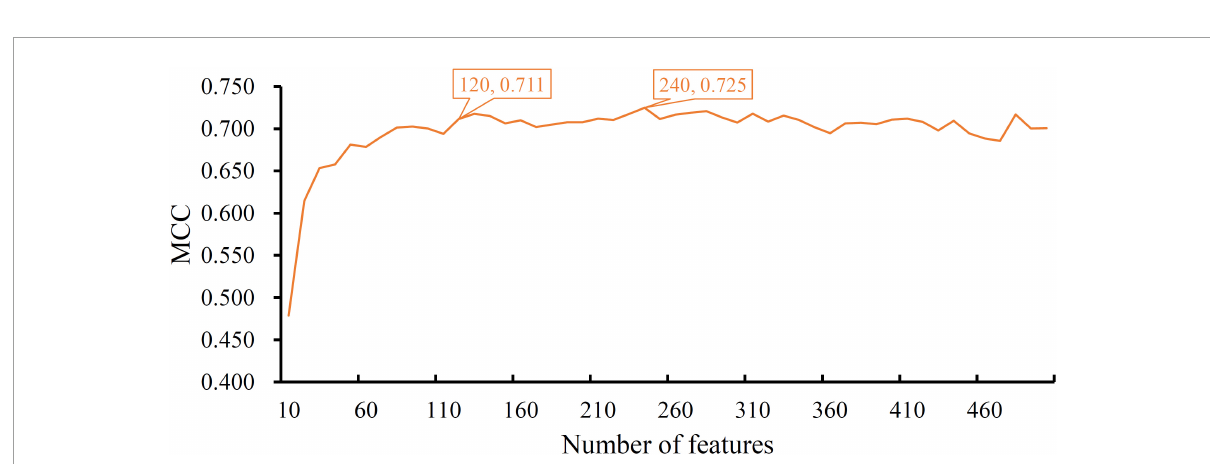
FIGURE4 The IFS curve of RF between 10 and 500. The RF classifier with top 120 features yielded a little lower MCC than the classifier with top 240 features, which is the optimal RF classifier.